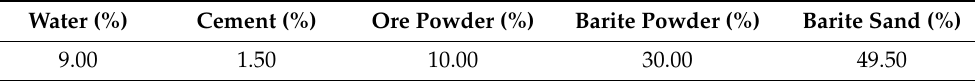
Table 1. The mixing ratio of various